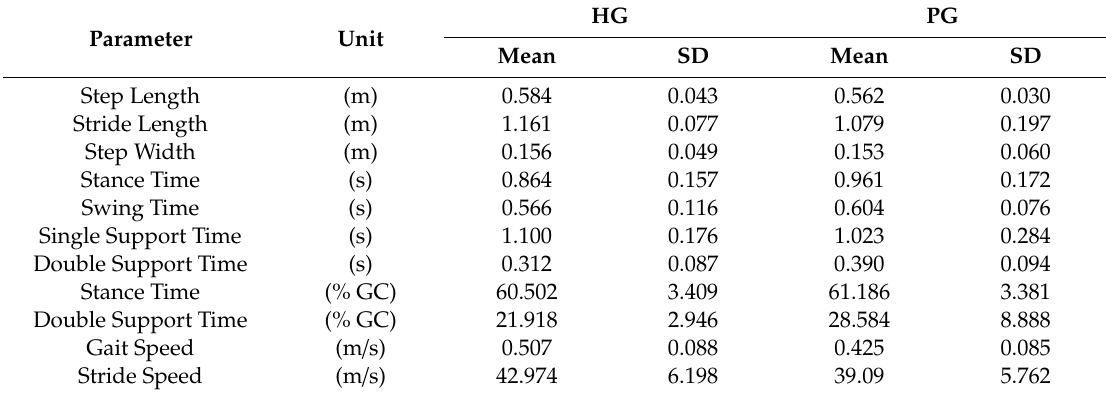
Table5. Meanandstandarddeviation(SD)ofhealthygroup(HG)andACLRgroup(PG)forallvariables.